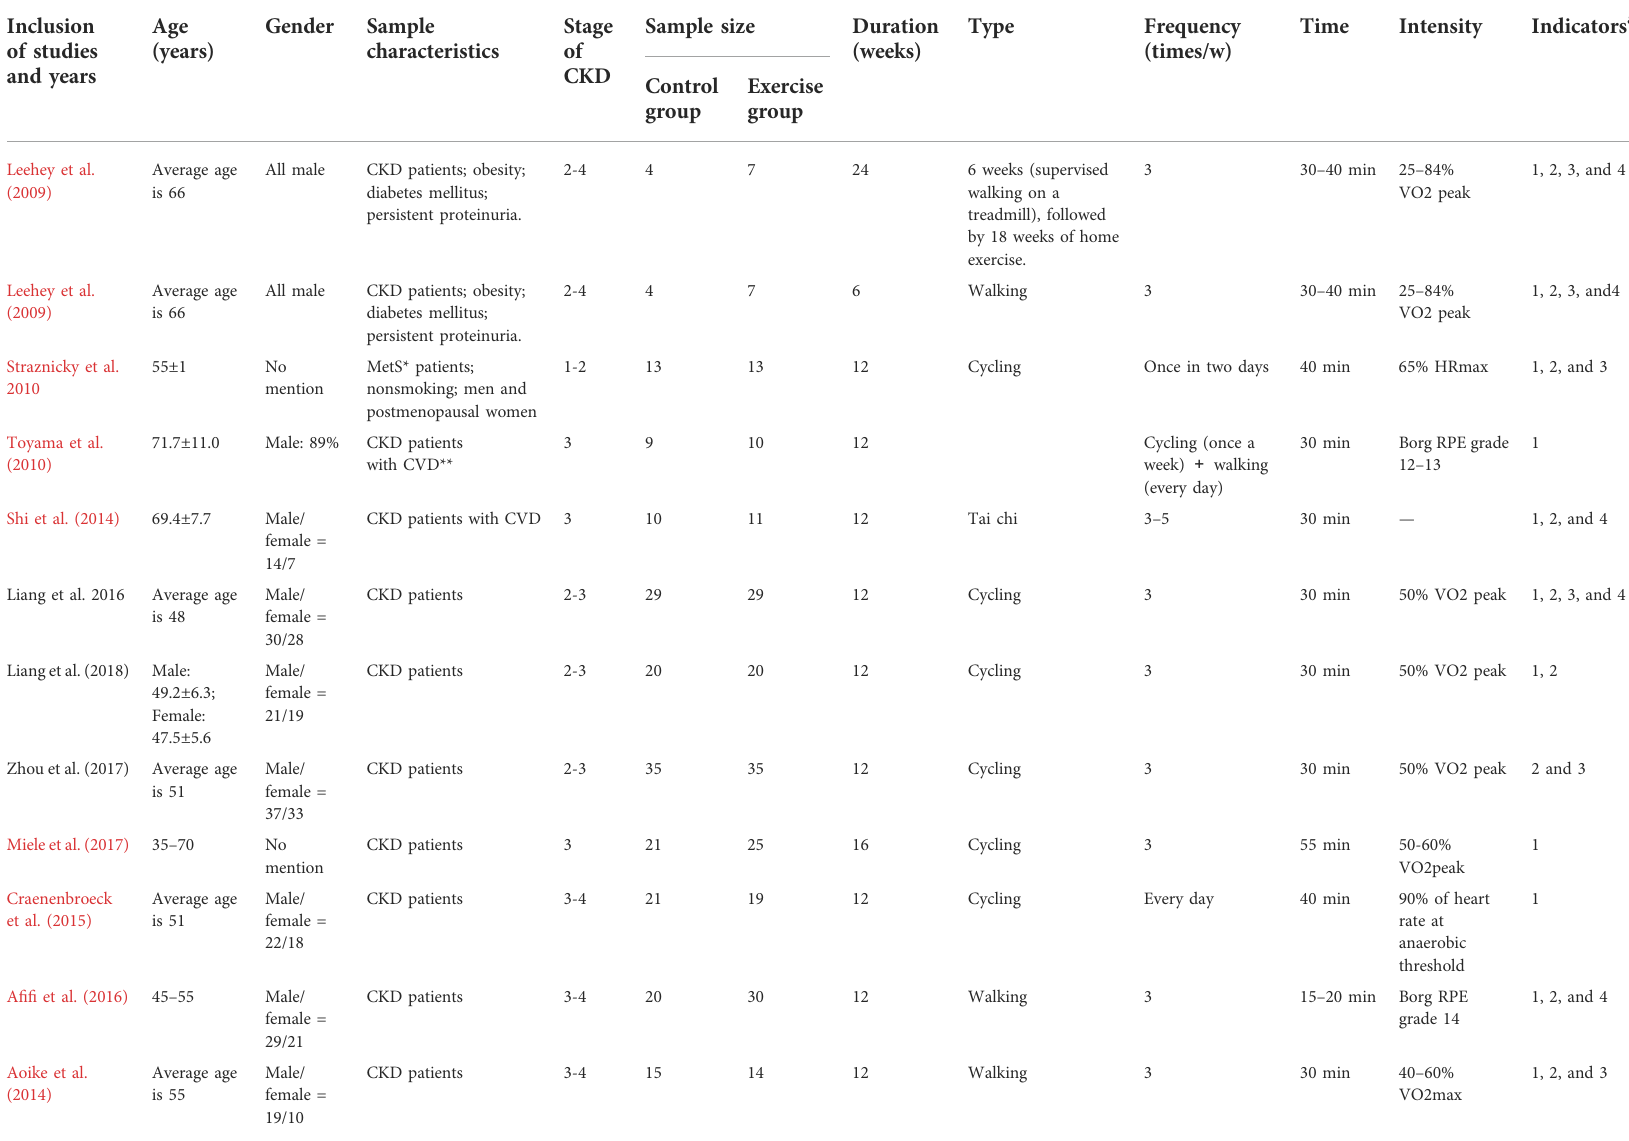
TABLE 1 Basic information table of included